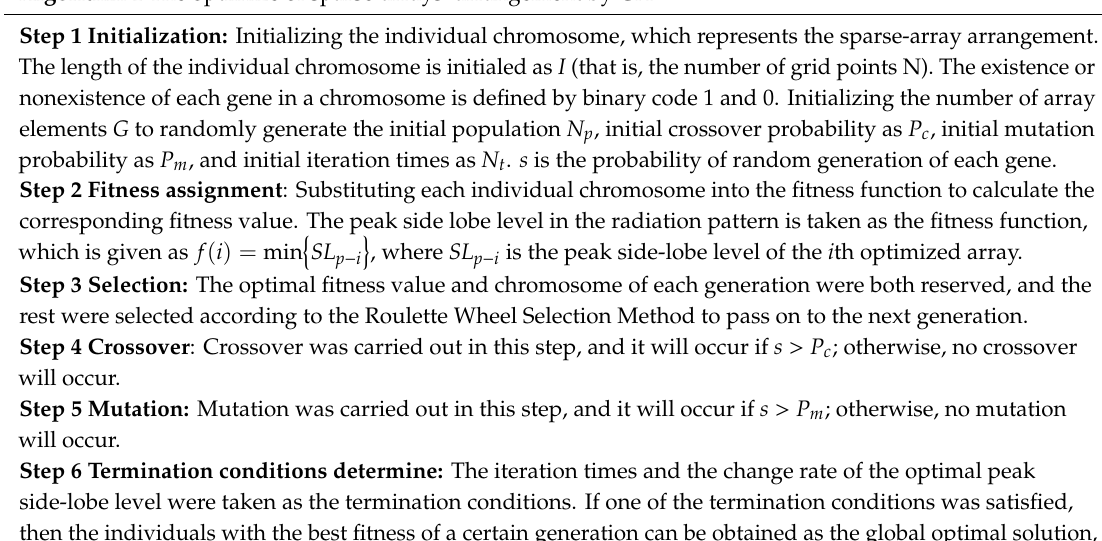
Algorithm 1 The optimize of sparse-arrays’ arrangement by GA